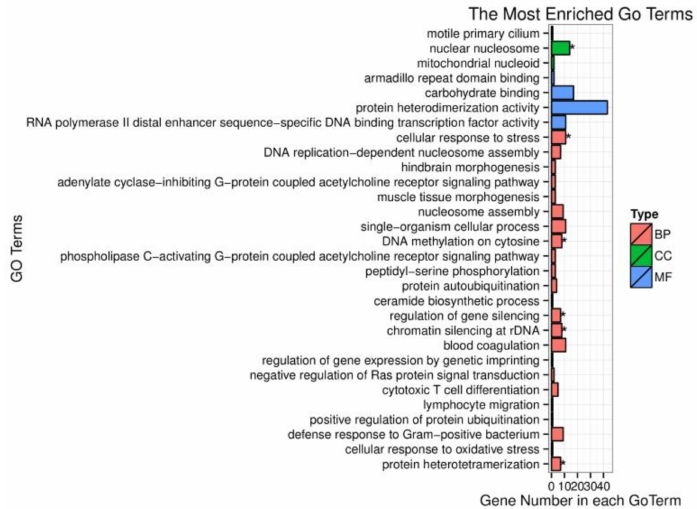
Figure 3. Gene ontology (GO) enrichment analysis of di ff erentially expressed miRNA target genes. BP represents biological process; CC represents cellular component; MF represents molecular function; the symbol * means p -value < 0.05.